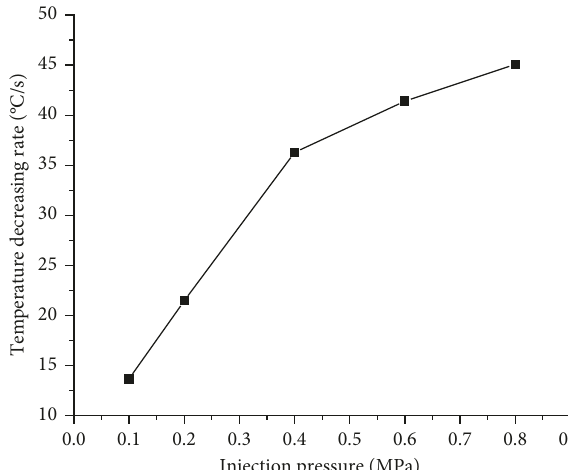
Figure 5: Rate of temperature decrease as a function of different injection